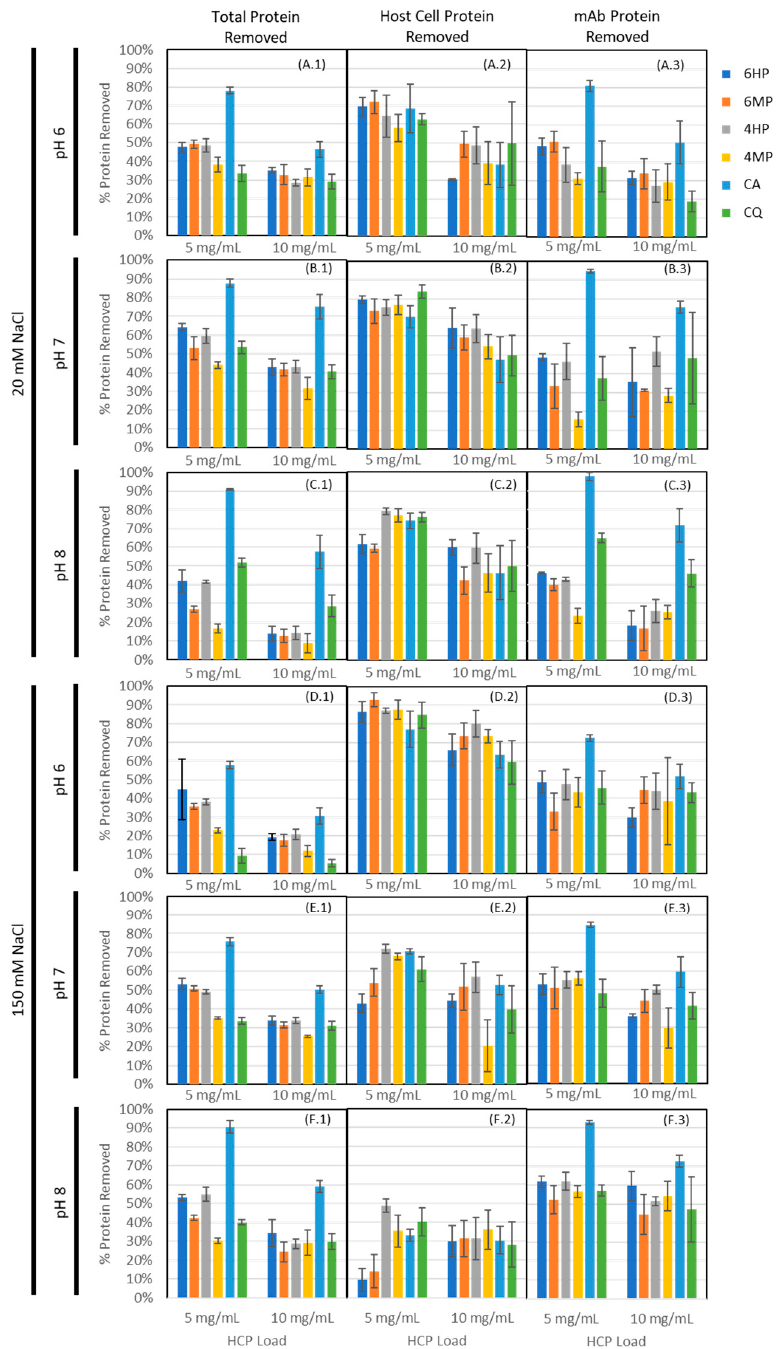
Figure 4. Protein removal (N = 3 for each condition) by hexameric hydrophobic positive and multipolar (6HP and 6MP, respectively) and tetrameric hydrophobic positive and multipolar (4HP and 4MP, respectively) lead HCP-binding peptide ligands coupled to Toyopearl Amino-650M resin in static binding mode, as compared to commercial resins Capto Adhere and Capto Q. Panels A.1–F.1 indicate total protein removal as measured using a Bradford assay. Panels A.2–F.2 indicate CHO-K1 host cell protein removed as measured using a Cygnus CHO HCP ELISA, 3G assay kit. Panels A.3–